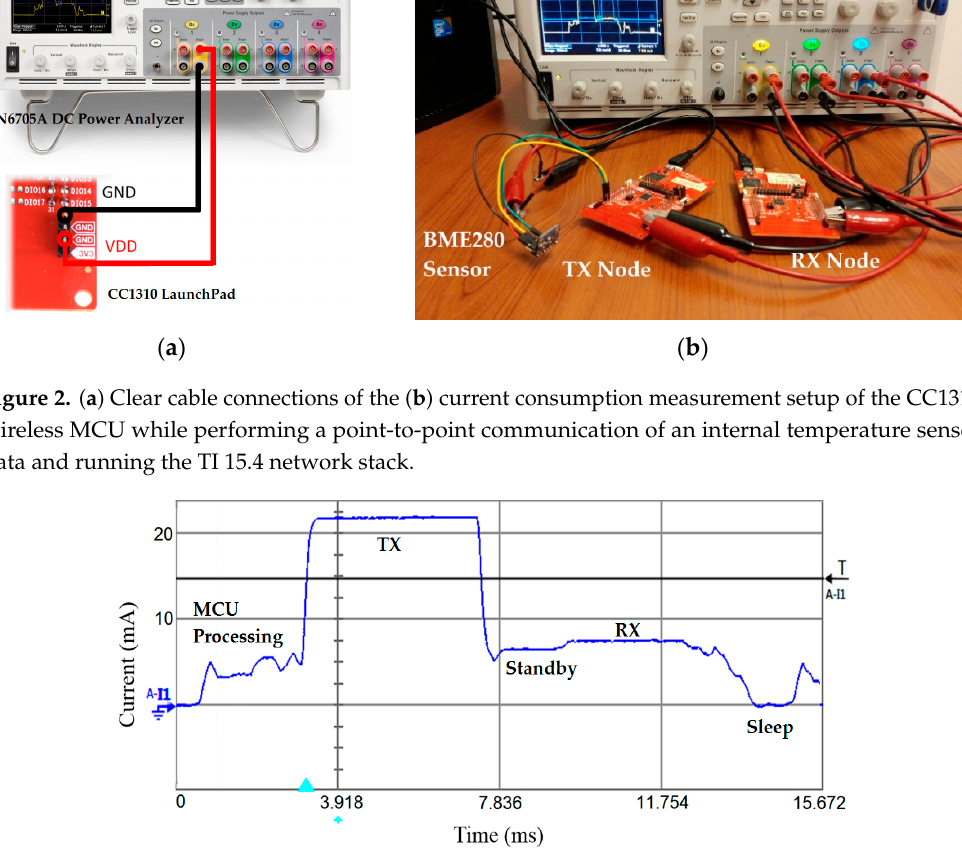
Figure 3. Current consumption profile of the CC1310 wireless MCU on the transmitter’s side.